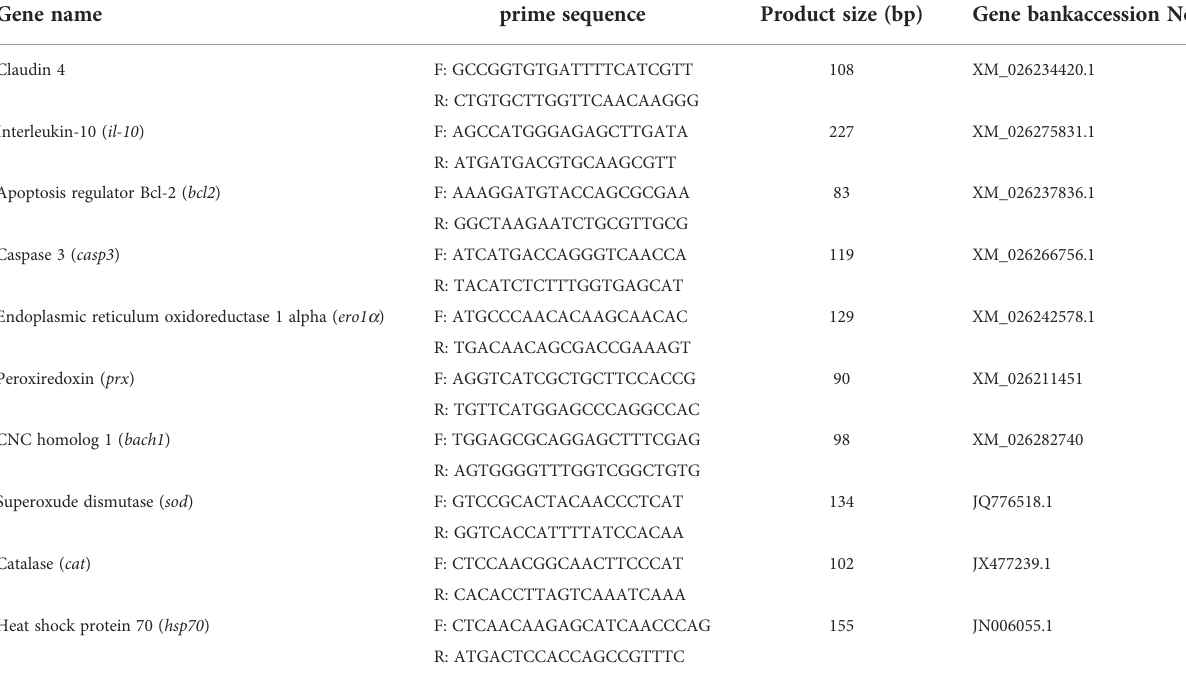
TABLE 1 Sequences of primers applied for quantitative real-time PCR analysis in gibel